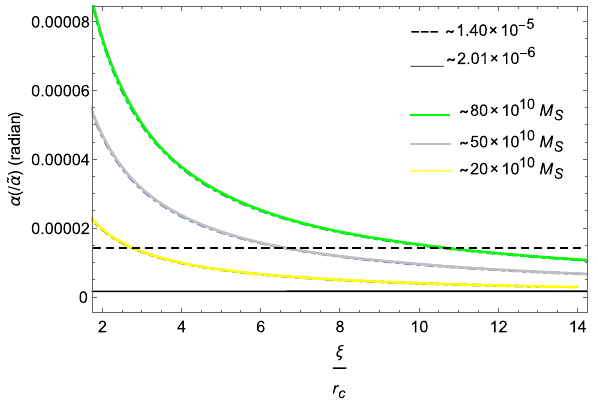
Fig. 6 The plot shows the deflection angle (in arcsec) as a function of lens mass M in the GR theory with δ = 0 in Eq. (39). The horizontal (dashed) gray lines correspond to the minimum and maximum values of the deflection angles observed for the considered different typical massive galaxies of mass M as in Fig. 5 [91]. We plot the curves for two typical impact parameter values 6 kpc and 12 kpc, respectively. It is seen that as the impact parameter increases, the deflection angle decreases for a particular galactic